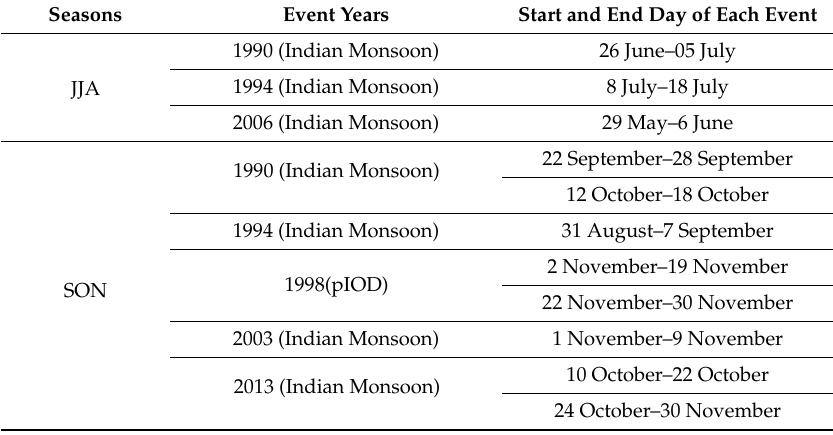
Table 1. The extreme high streamflow events at Andhiyarkore station for June, July, and August (JJA) and September, October, and November (SON) seasons, where each event is selected from the persistence occurrence of high flows for 6 days or more (1980–2013). pIOD in table is positive IOD.